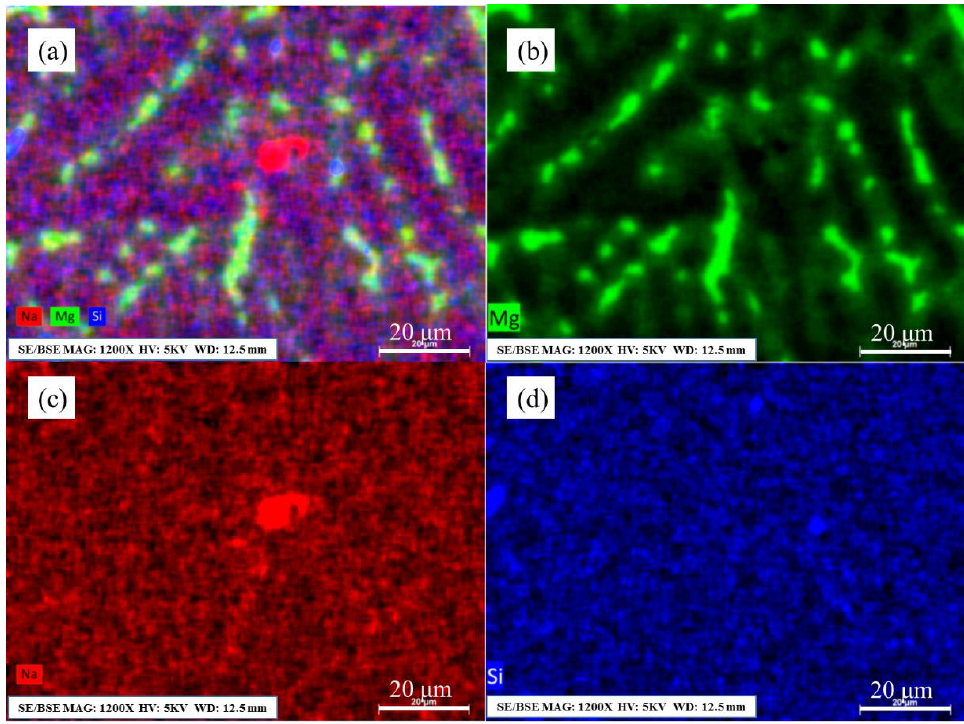
Figure 6. Elemental distribution of Na, Mg and Si in as-cast Al – 10Mg alloy ( a ) Na, Mg and Si; ( b ) Mg; ( c ) Na; ( d ) Si.